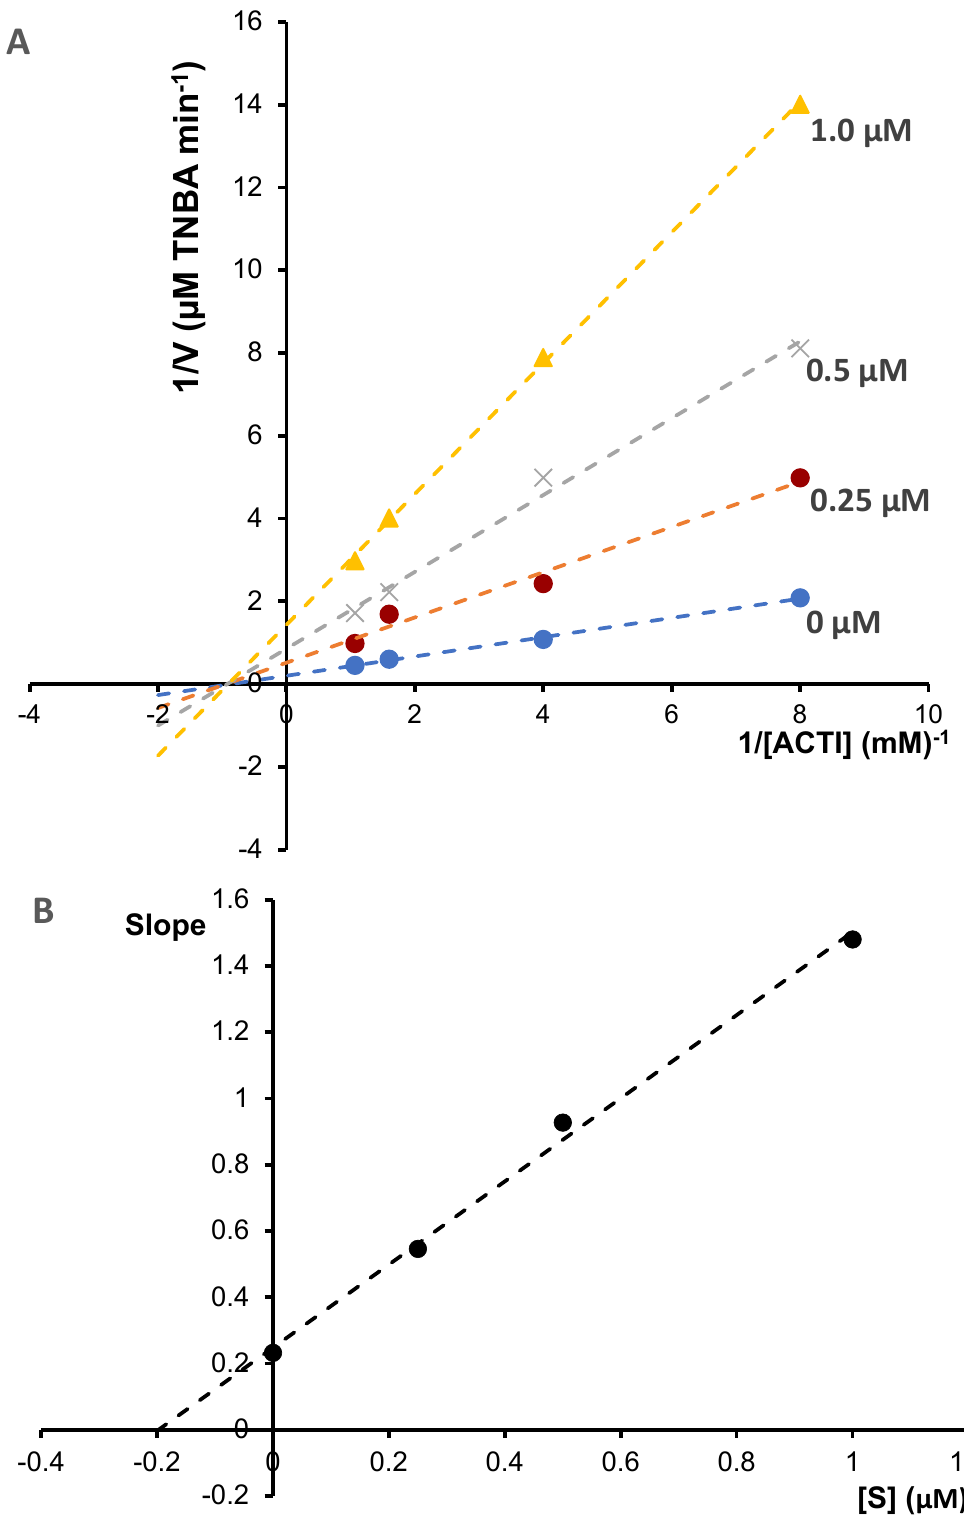
Figure 5. ( A ) Lineweaver–Bulk plot of acetylcholinesterase activity over a range of substrate concentration for chelerythrine, ( B ) determination of inhibition constants (K i ) by plotting the slope of the primary Lineweaver–Burk plot vs. chelerythrine concentration.